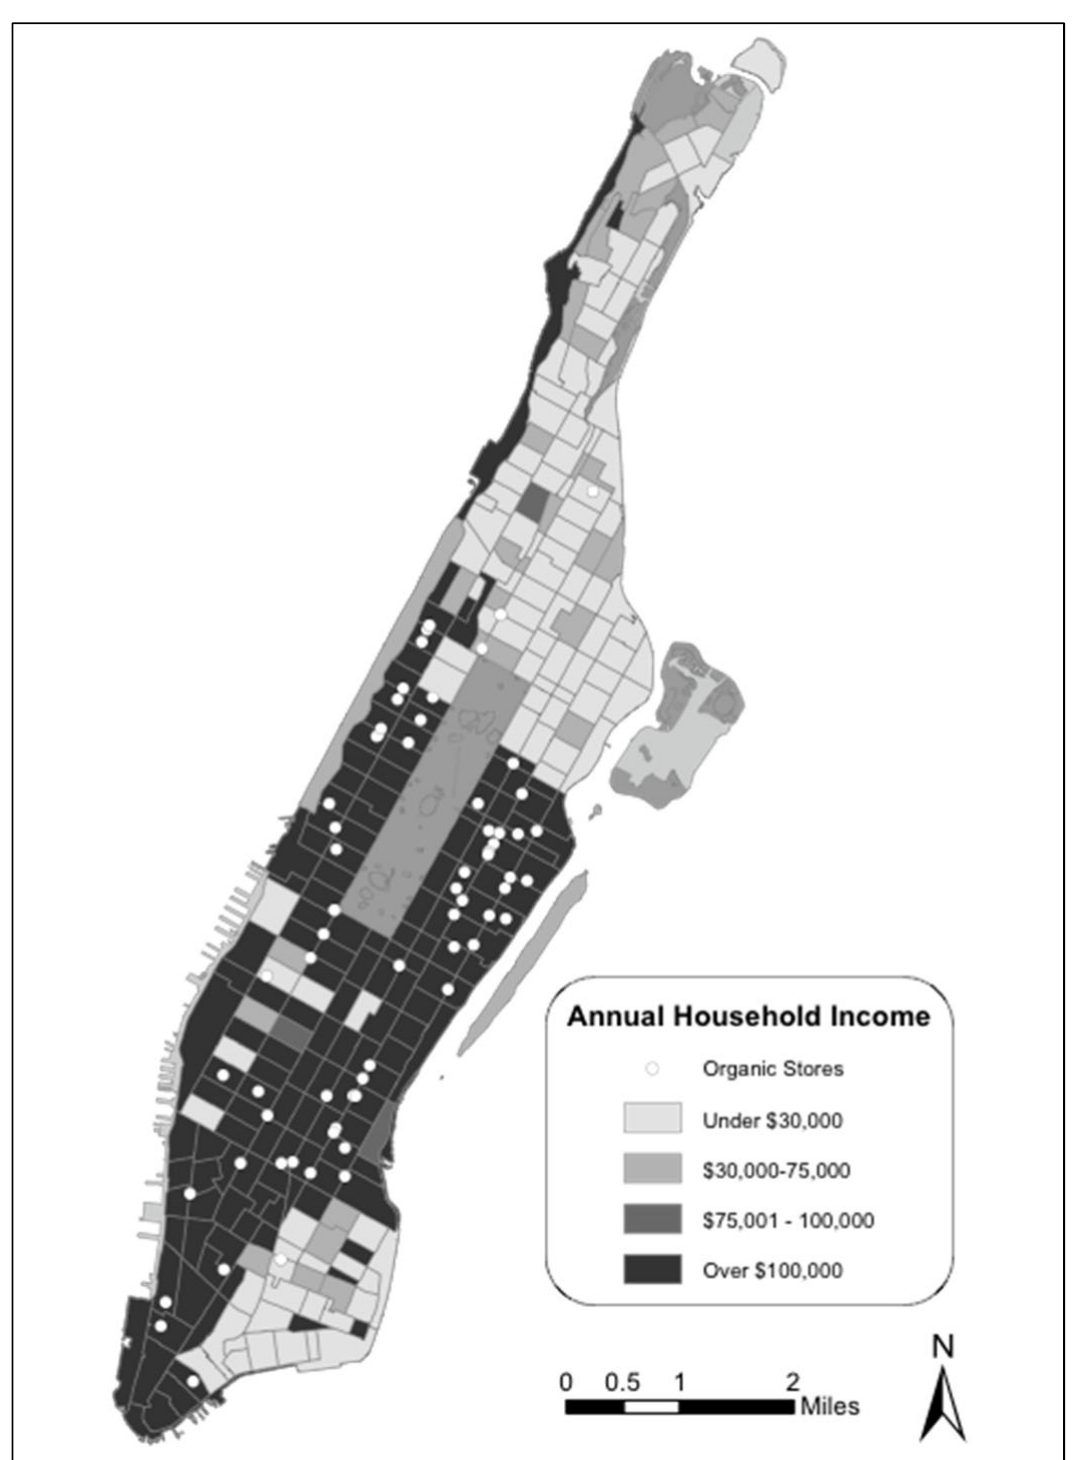
Figure 4. Organic Food Availability and Income, Manhattan, New York, January